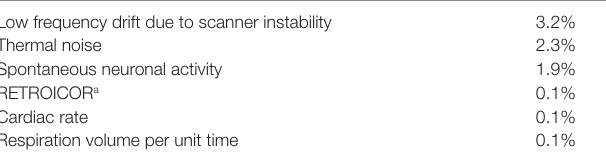
TABLe 2 | Contributions to rs-fMRi signal change in whole brain gray matter at voxel level in 7